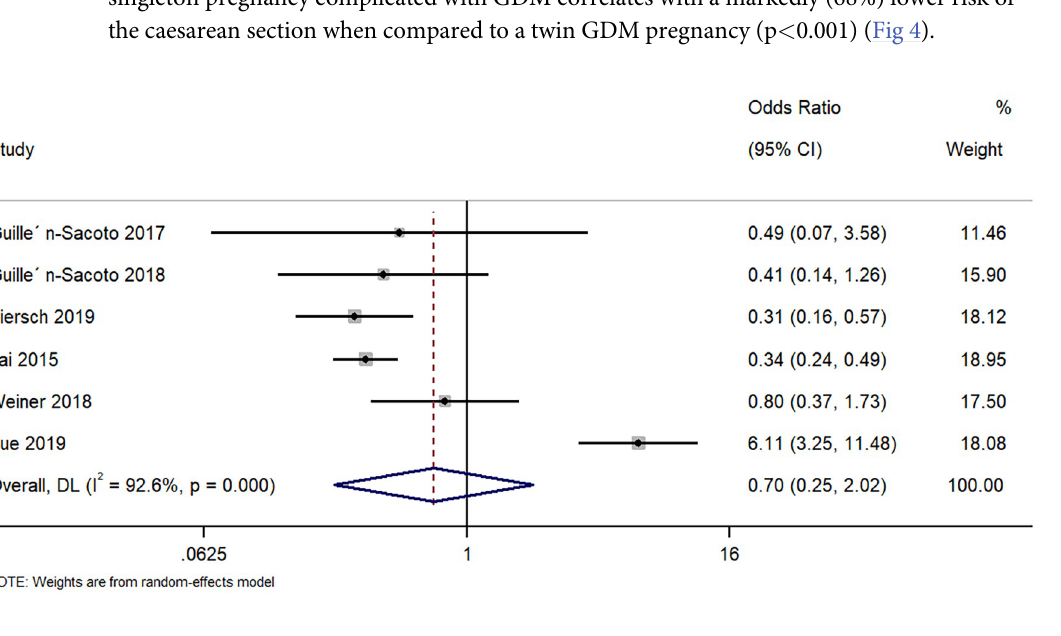
Fig 3. Forest plot showing the difference in pre-eclampsia between women with a singleton pregnancy or twin pregnancy and GDM. NOTE: Weights are from random-effects model.